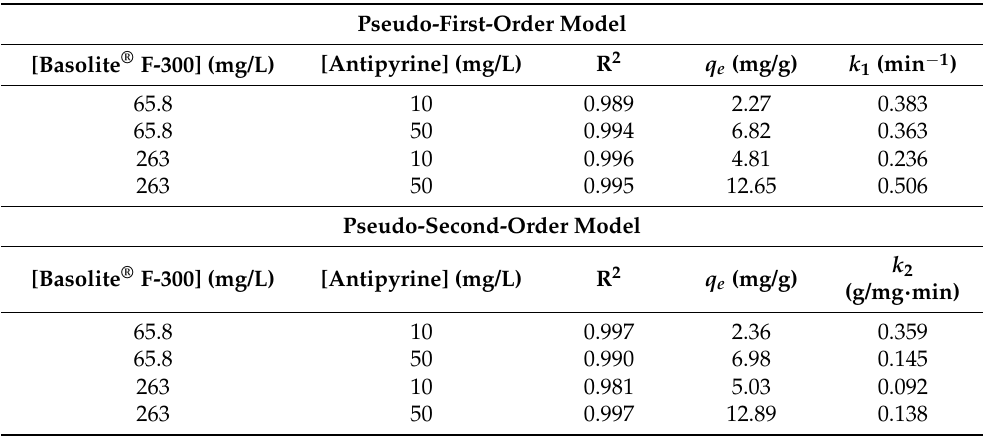
Table 4. Obtained parameters from the adsorption kinetics fittings in the removal of the antipyrine with a certain concentration of Basolite ®